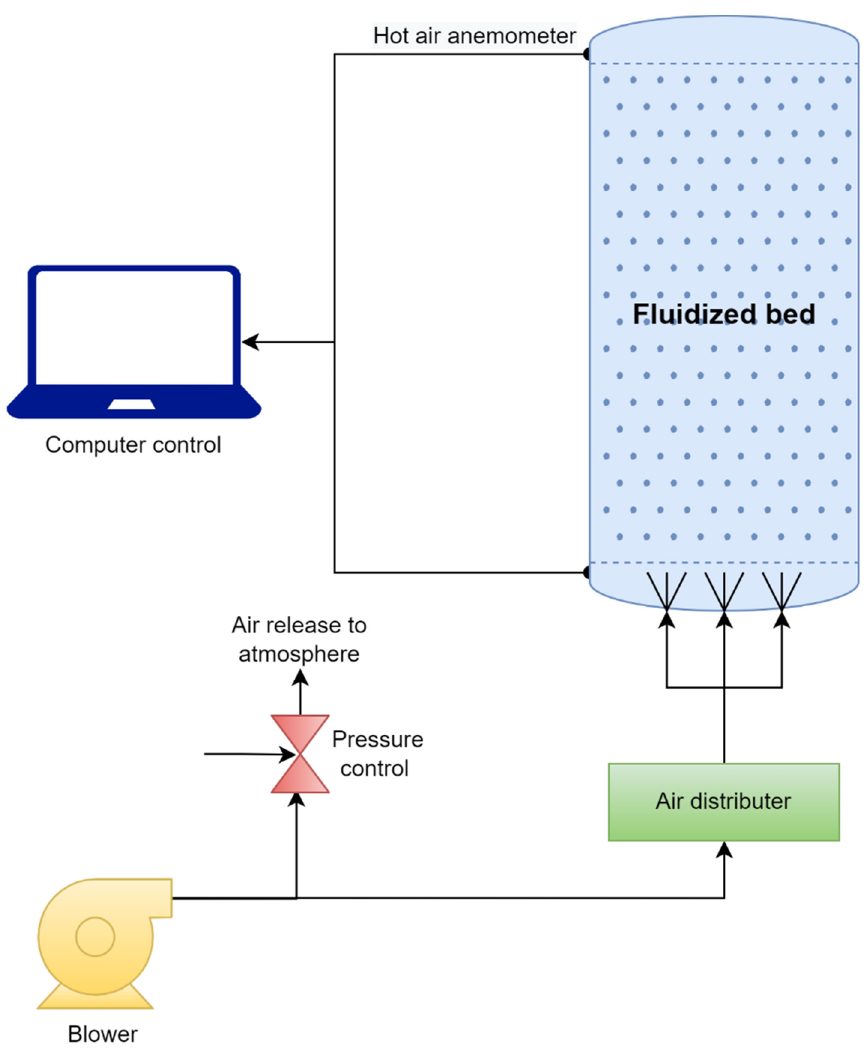
Figure 5. Fluidized-bed reactor adapted adapted from